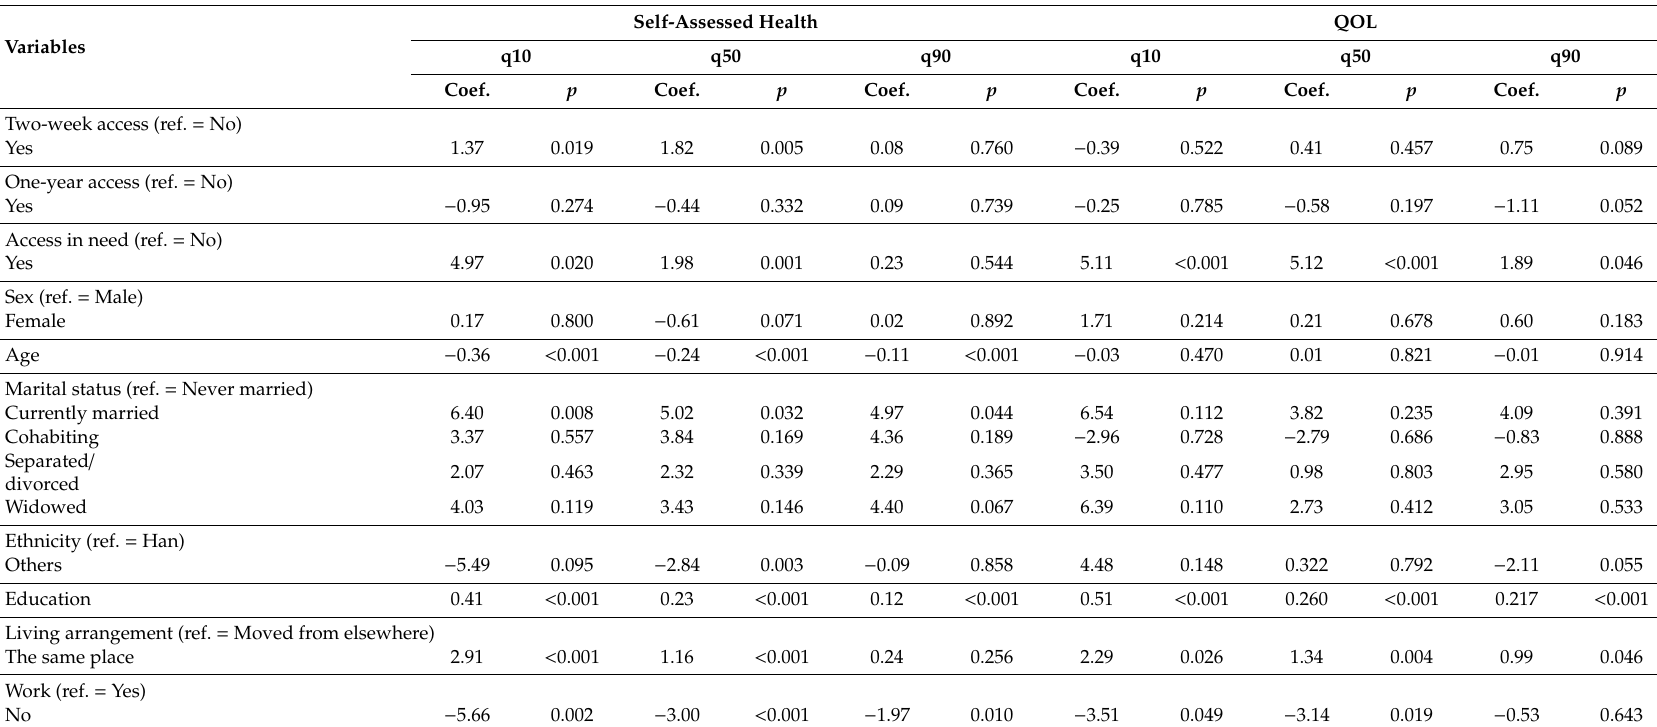
Table 2. Quantile regression results for self-assessed health and quality of life (QOL) using urban data ( n = 3194).